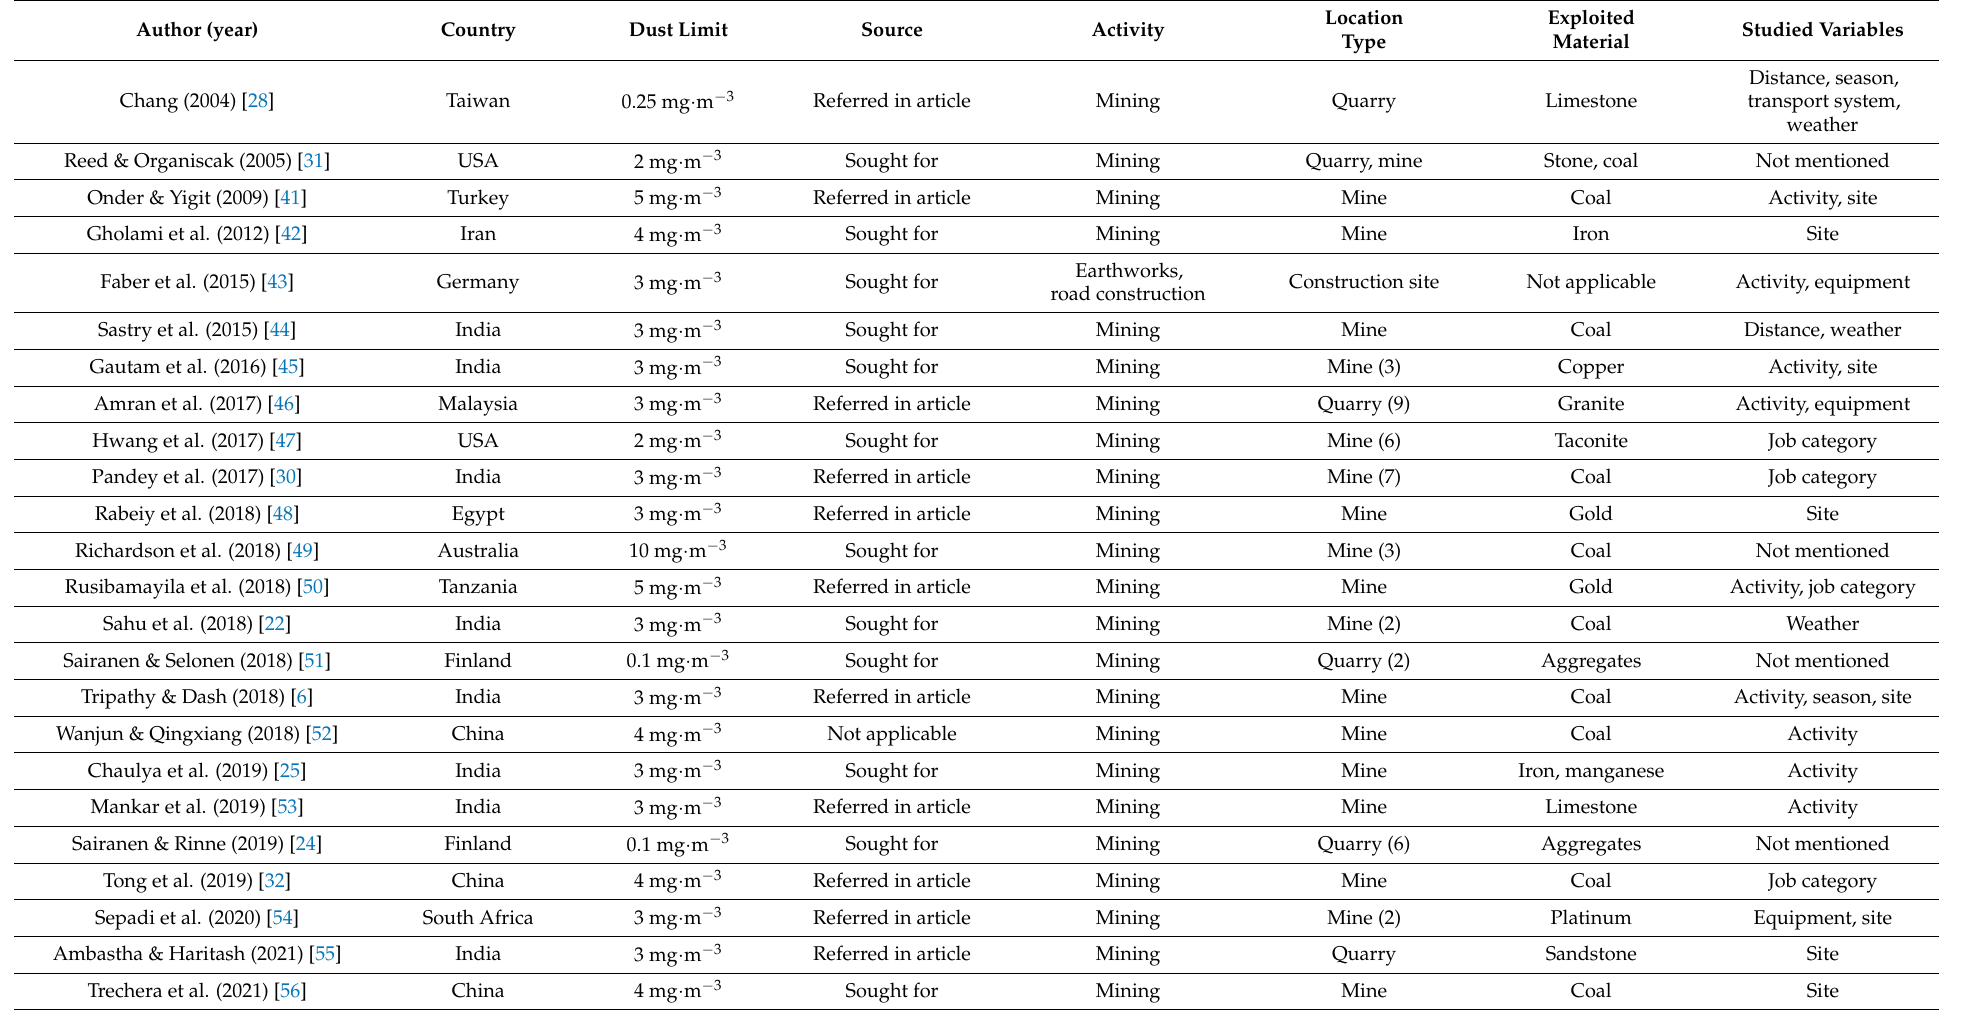
Table 1. Study analysis regarding dust-exposure limit, activity and location, exploited material, and